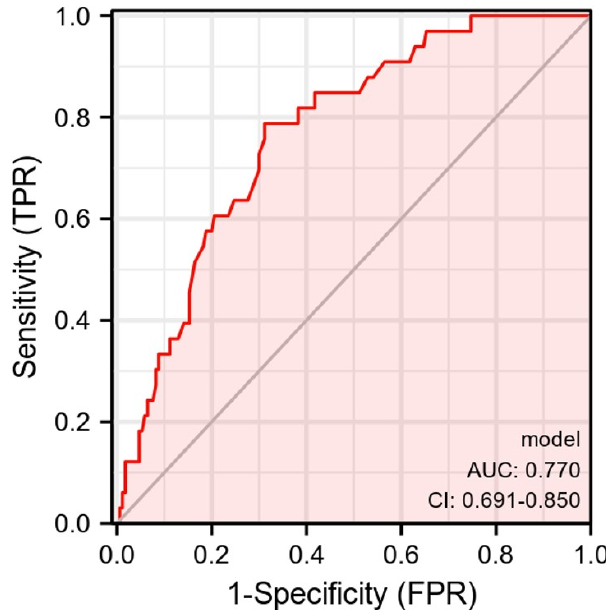
Figure 3. ROC curve of the alexithymia risk-prediction model.